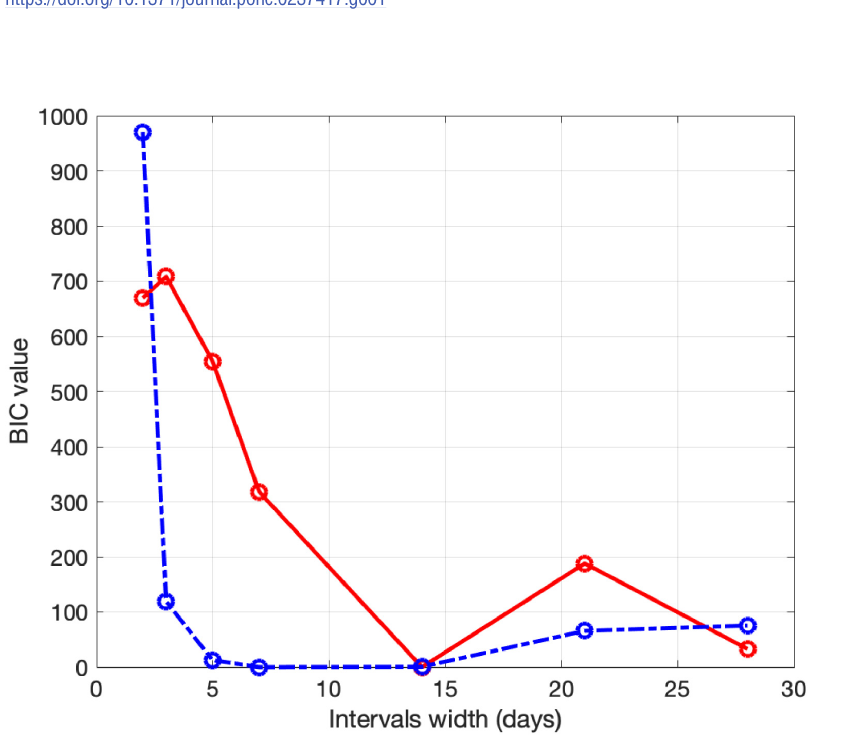
Fig 1. BIC parameters for Emilia-Romagna. Scaled BIC parameters Δ ( BIC ) 7, 14, 21, 28} with fSEIRDe (red continuous line), fSEIRDr (blue dash-dotted line) models.